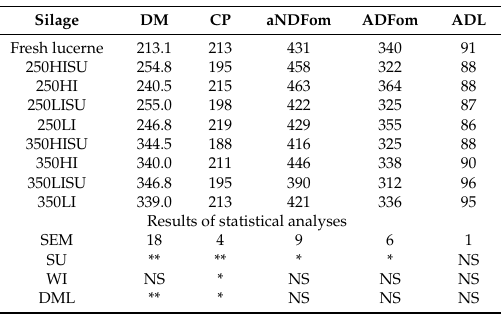
Table 1. Effect of sucrose addition (SU), wilting intensity (WI), and dry matter (DM) level (DML) on DM content (g kg − 1 ), crude protein content (g kg − 1 DM), and fibre fractions (g kg − 1 DM) in lucerne silages (fresh lucerne values are provided as ease for comparison).